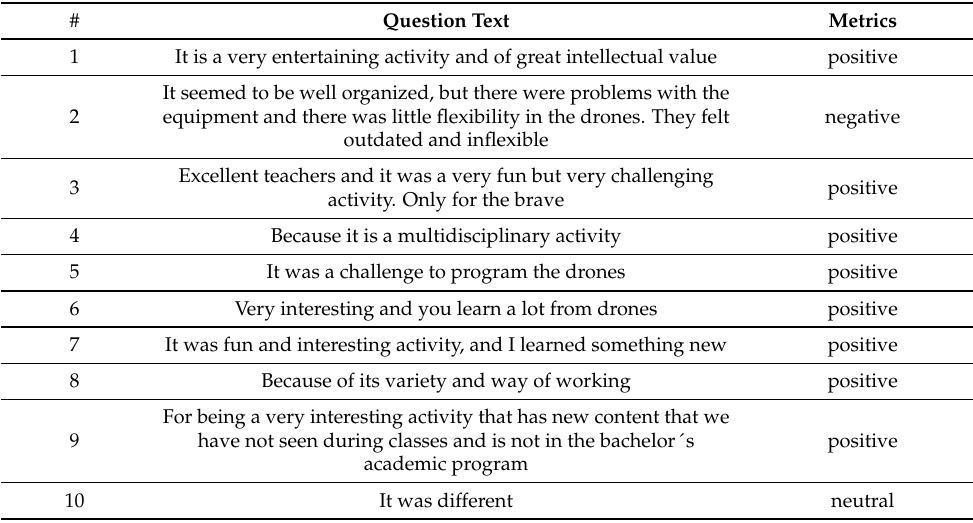
Table 7. Comments associated with the questions Q11 and Q12 in the